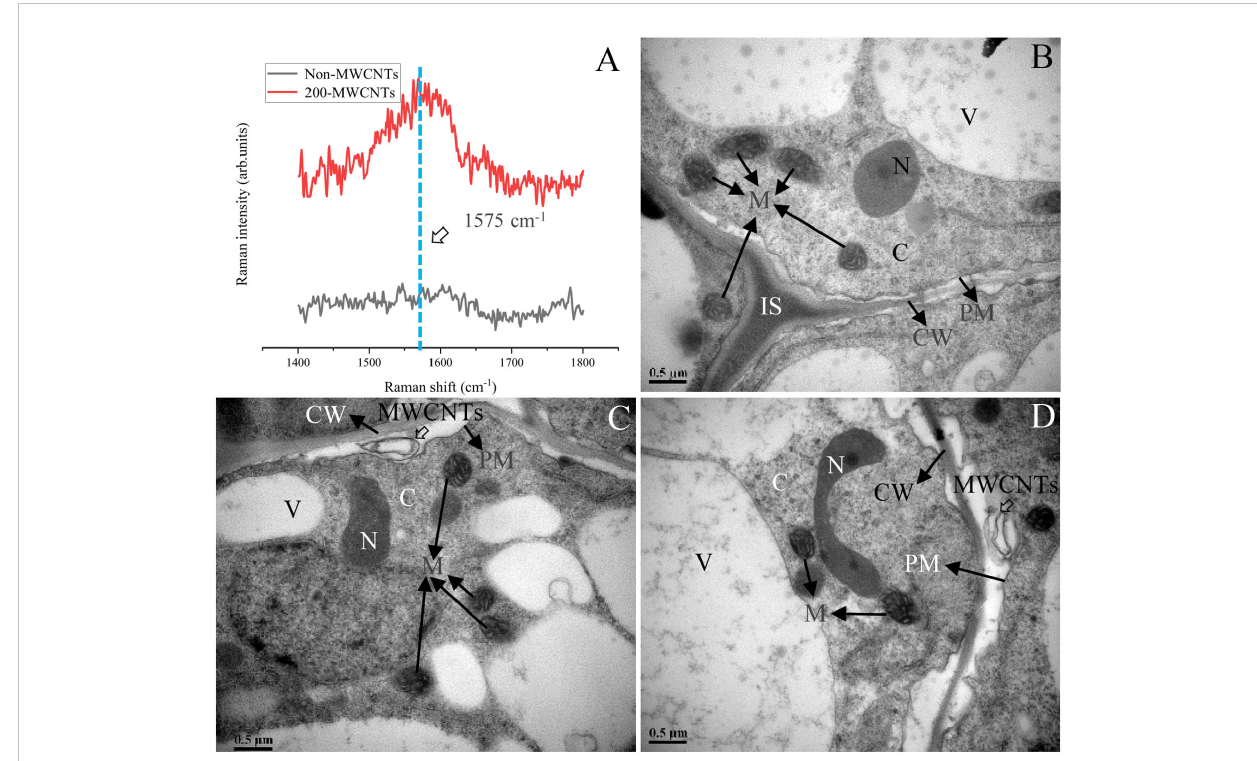
FIGURE 6 Raman analysis of the Malus hupehensis seedlings roots following the control (Non-MWCNTs) and 200 µg·mL -1 MWCNTs (200-MWCNTs) treatments (A) . TEM images of the Malus hupehensis seedlings roots following the control (B) and 200 µg·mL -1 MWCNTs (C, D) for 30 days. Black solid and hollow arrows in (B – D) point to organelles and MWCNTs, respectively, scale bars=0.5 µm. CW, cell wall; PM, plasma membrane; IS, intercellular space; N, nucleus; C, cytoplasm; M, mitochondria; V,